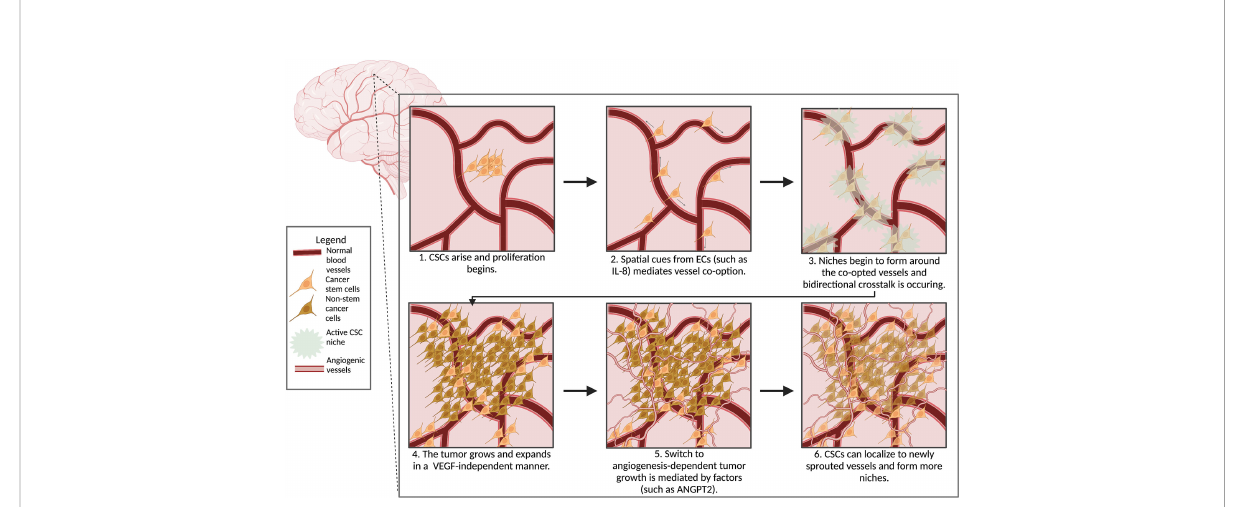
FIGURE 2 Scheme for the development of GBM CSC niche. Objects are not to